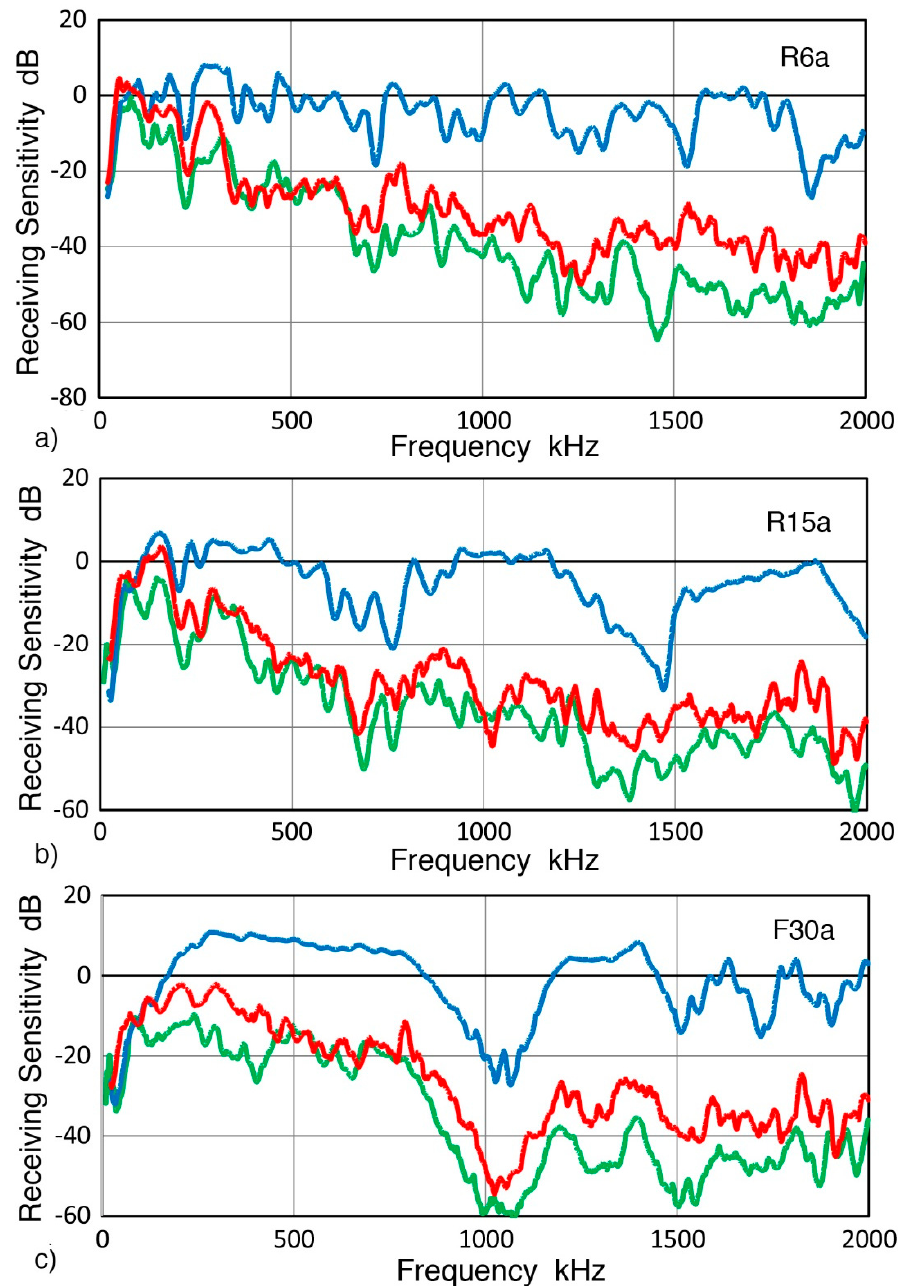
Figure A1. Receiving sensitivities of three AE sensors to three wave modes, NW (blue curves), RW (green curves), and GW (red curves). ( a ) R6a sensor, ( b ) R15a sensor, and ( c ) F30a sensor.